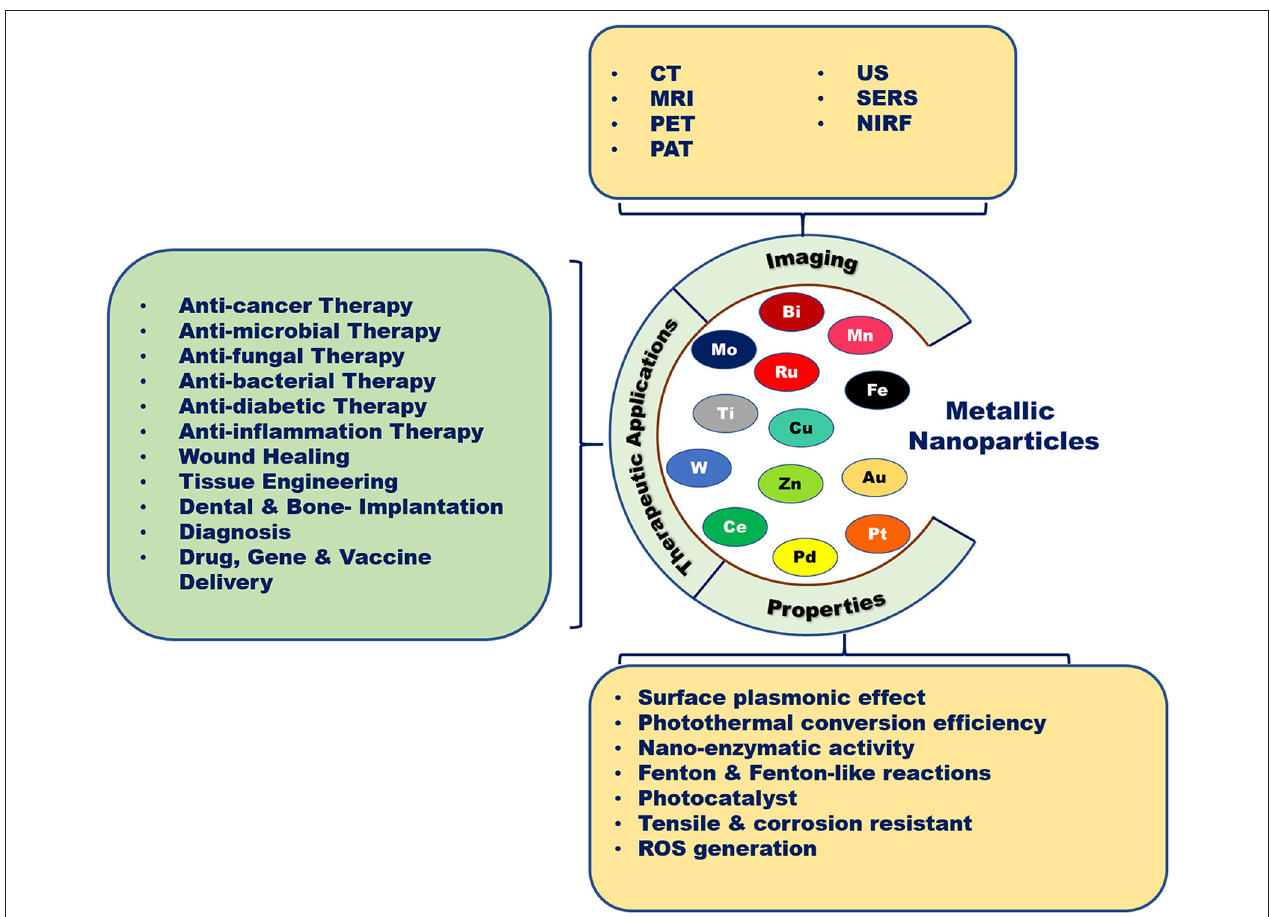
FIGURE 1 | Biomedical applications of metallic nanoparticles. Metallic nanoparticles are used as potent candidates for different types of diseases due to their unique properties and imaging characteristics.